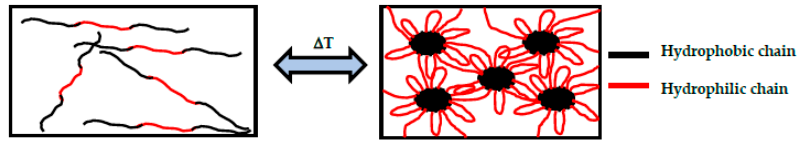
Figure 4. Thermo-responsive hydrogels. These amphiphilic block copolymers undergo a sol-to-gel phase transition in aqueous media. At temperatures lower than the critical gelation temperature (CGT), these polymeric solutions are homogenous and injectable. Whereas at temperatures higher than the CGT, a 3-dimensional structure of bridged micelles, dominated by hydrophobic interactions, is formed.